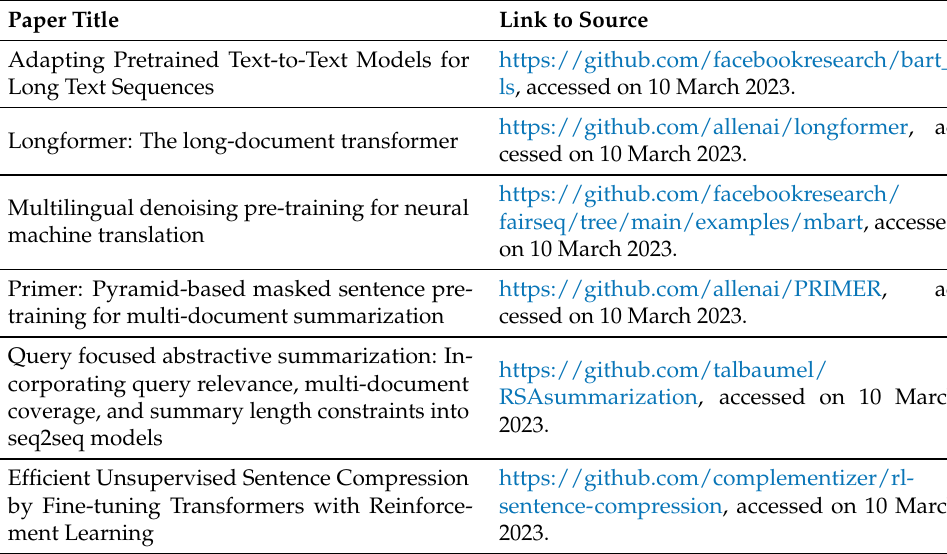
Table 6. Source code links for Text